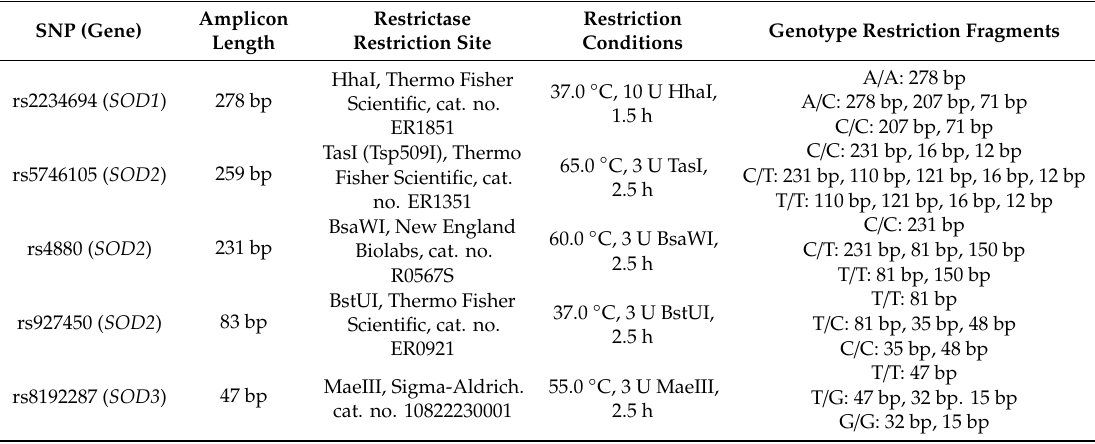
Table 15. Restriction conditions (PCR-RFLP method